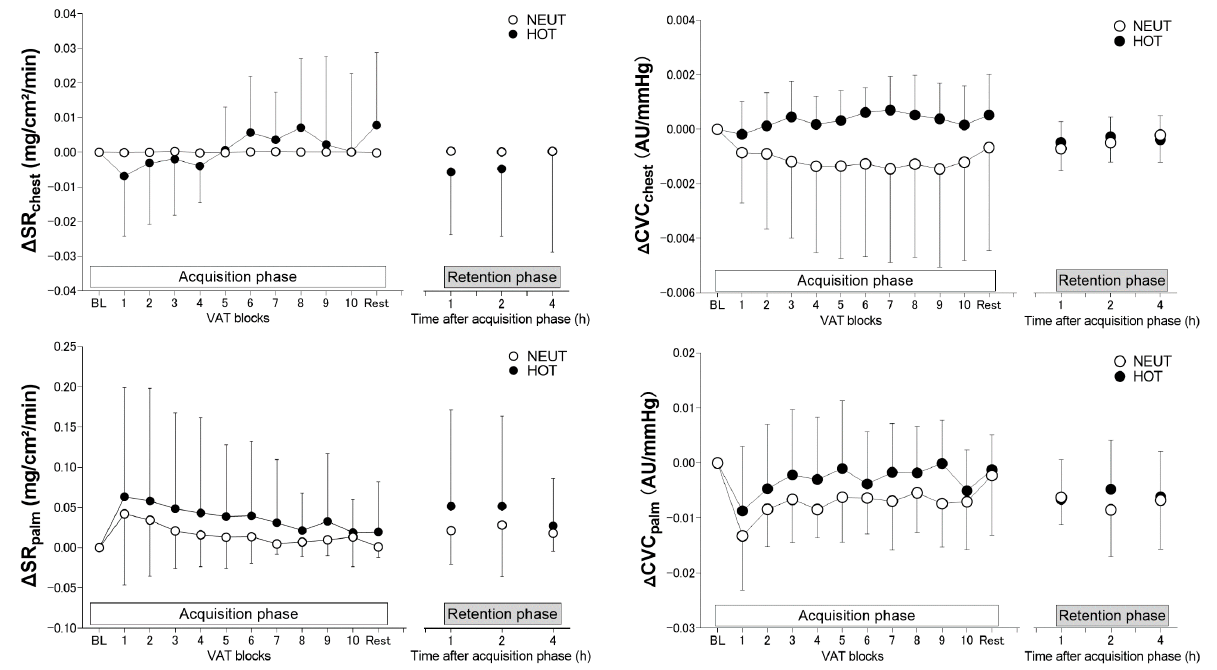
Figure 5. Changes from baseline (BL) before each VAT trial in sweat rate on the chest ( ∆ SR chest , n = 14 and n = 15 for the NEUT and HOT conditions, respectively) and palm ( ∆ SR palm , n = 14 and n = 15, respectively), as well as cutaneous vascular conductance on the chest ( ∆ CVC chest , n = 13 and n = 15, respectively) and palm ( ∆ CVC palm , n = 12 and n = 15, respectively), during VAT tasks in thermoneutral (NEUT, n = 13) and hot (HOT, n = 15) environments for acquisition (left panel) and retention (right panel) phases. Values are presented as means ± SD.